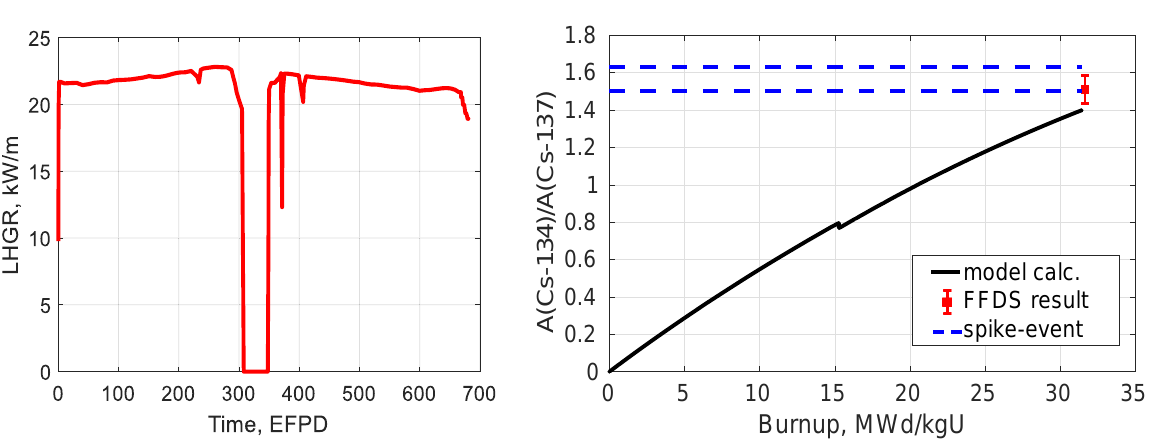
Figure 5. TVSA-12 #2, suspect rod: average LHGR and comparison of 134 Сs/ 137 Cs activity